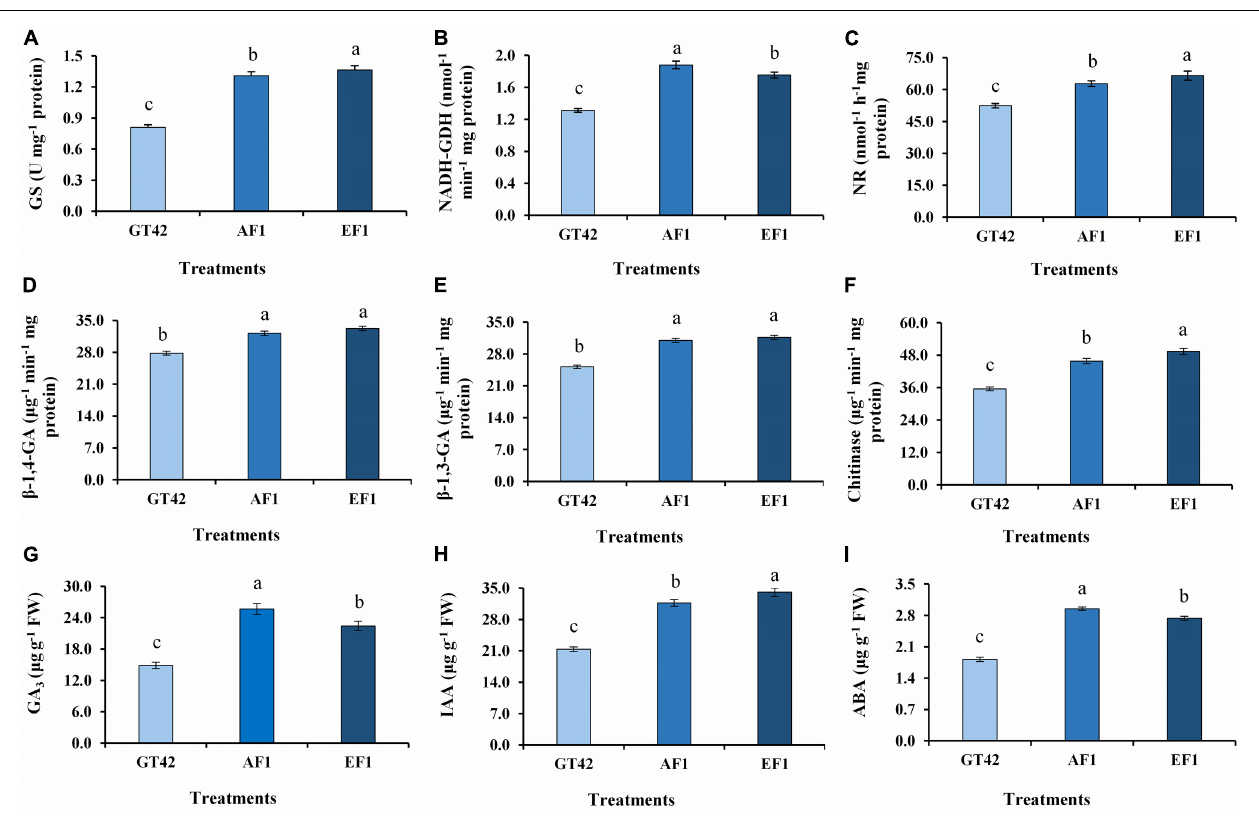
FIGURE 10 | Analysis of N-metabolism enzymes, hydrolytic enzymes, and hormone activities in root tissues of sugarcane (GT42) inoculated with P. cypripedii AF1 and K. arachidis EF1. (A) Glutamine synthetase, (B) glutamate dehydrogenase, (C) nitrate reductase, (D,E) β -1,4 and β -1,3 glucanase, (F) chitinase, (G) gibberellins, (H) indole-3-acetic acid, and (I) abscisic acid. Different lowercase letters display a significant difference at p ≤ 0.05.